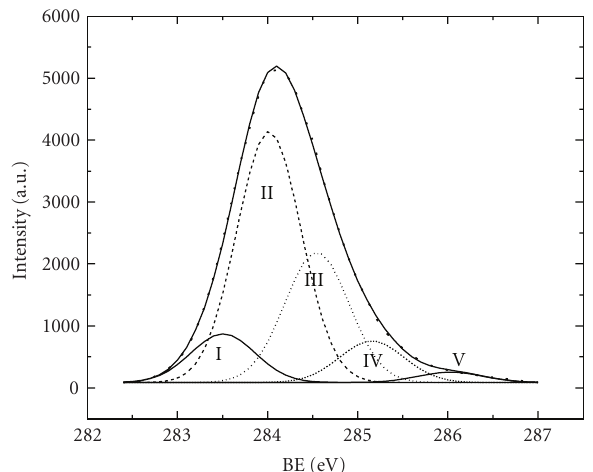
Figure 4: C1s XPS spectra of undoped NCD film grown on a silicon